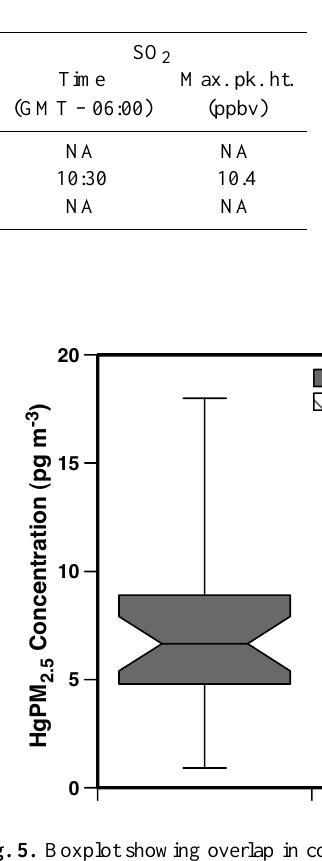
Table 2. RGM and SO 2 peak arrival time for 23 September 2007, showing simultaneous arrival of these maxima at the 50km site and first arrival of peak RGM at the 100km site.